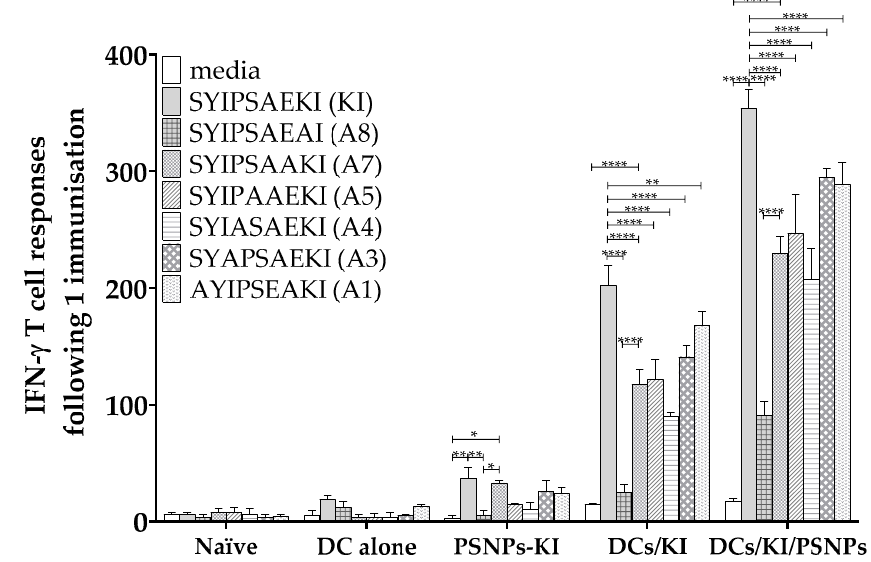
Figure 3. Differential response to alanine screened altered variants of SYIPSAEKI when conjugated to PSNPs or pulsed with DCs. The 6–8 week old BALB/c mice were immunized once with PBS alone, DCs alone (1 × 10 6 DCs per mouse), KI conjugated to PSNPs (PSNPs-KI, 25 µg per mouse KI and 1% solids PSNPs), ex vivo KI pulsed DCs (DCs/KI, DCs pulsed with 5 µg/mL KI and 1 × 10 6 cells immunized per mouse), or ex vivo KI pulsed DCs coinjected with mixed in PSNPs (DCs/KI/PSNPs, 1 × 10 6 cells injected with 0.67% PSNPs). Five weeks after the last immunization, splenocytes from immunized mice were harvested and restimulated with alanine altered peptides in an in vitro ELISpot assay for IFN- γ . Data shown as mean +/- SD of SFU/million cells per assay triplicates (pooled cells from four mice per group). * p < 0.05, ** p < 0.01, *** p < 0.001, **** p < 0.0001.